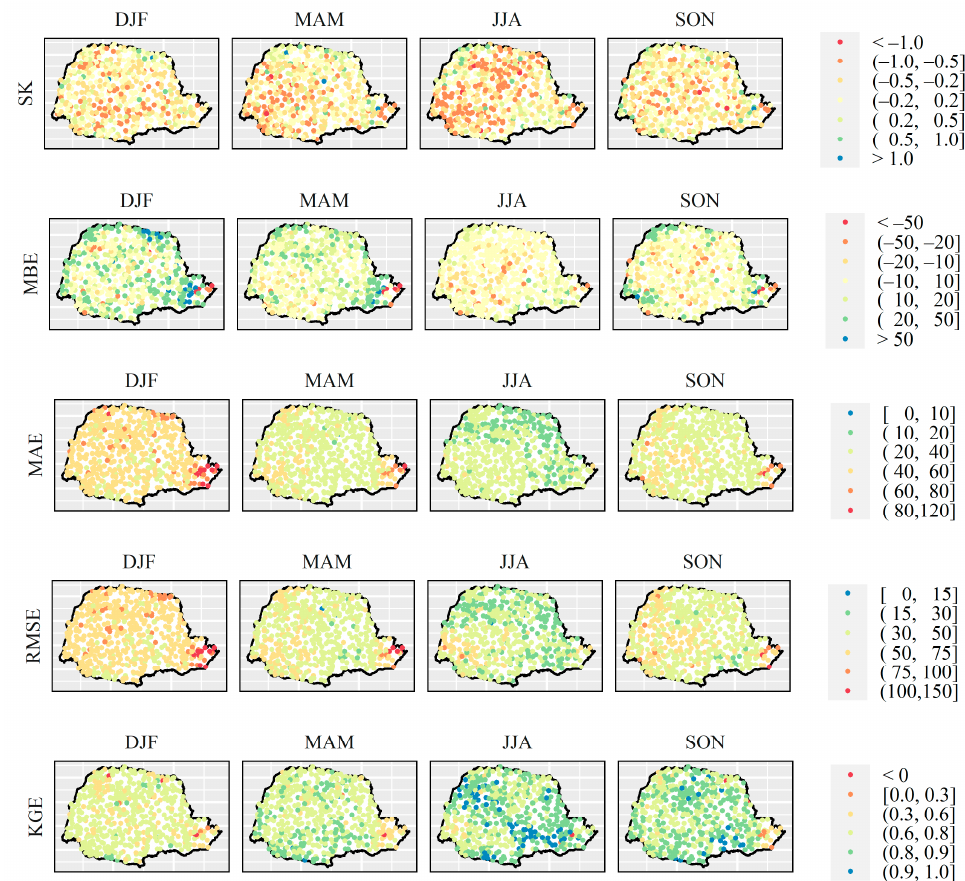
Figure 10. Seasonal distribution of the performance metrics for IMERG at a monthly scale.